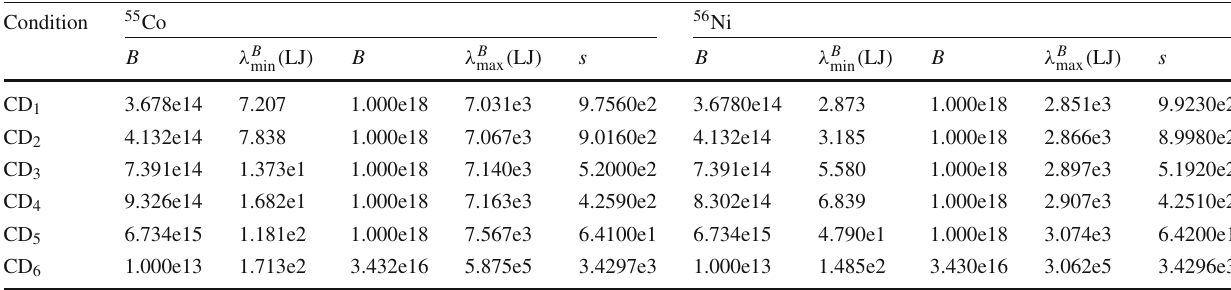
Table 1 Comparisons of the maximum value of our calculations λ B ( LJ ) with those of minimum value λ B max when 10 13 G ≤ B ≤ 10 18 G under the conditions CD i , i = 1– 6, corresponding to ρ 7 = 5 . 86 , Y e = 0 . 47 , T 9 = 3 . 40; ρ 7 =